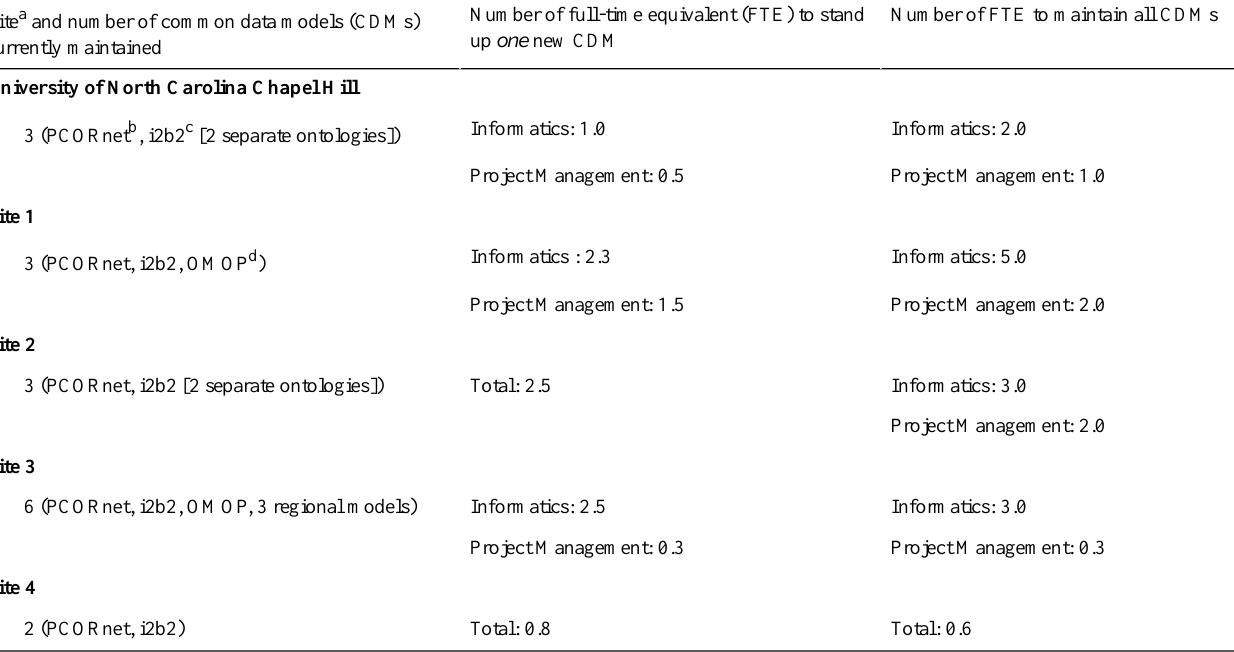
Number of FTE to maintain all CDMsNumber of full-time equivalent (FTE) to stand